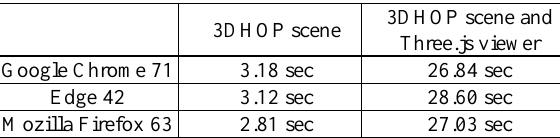
Table 1. Web rendering statistics for 3DHOP and Three.js using the network panel of the Developer